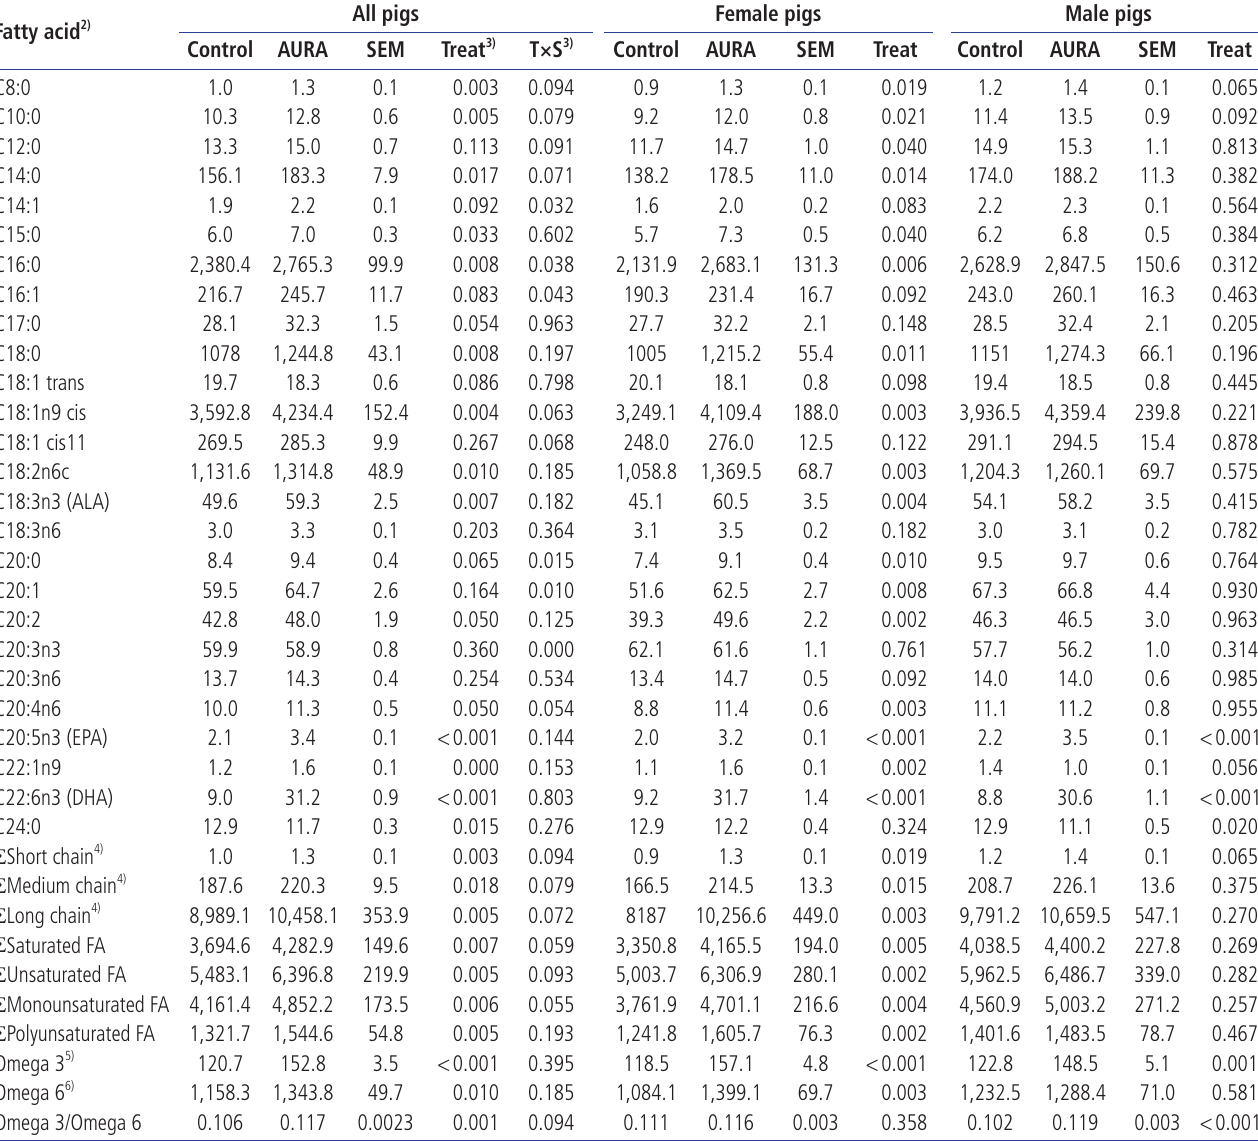
Table 5. Pork Longissimus lumborum (LL) fatty acid (FA) profile (mg/100 g tissue) for control and AURA 1) supplemented pigs All Fatty acid 2)